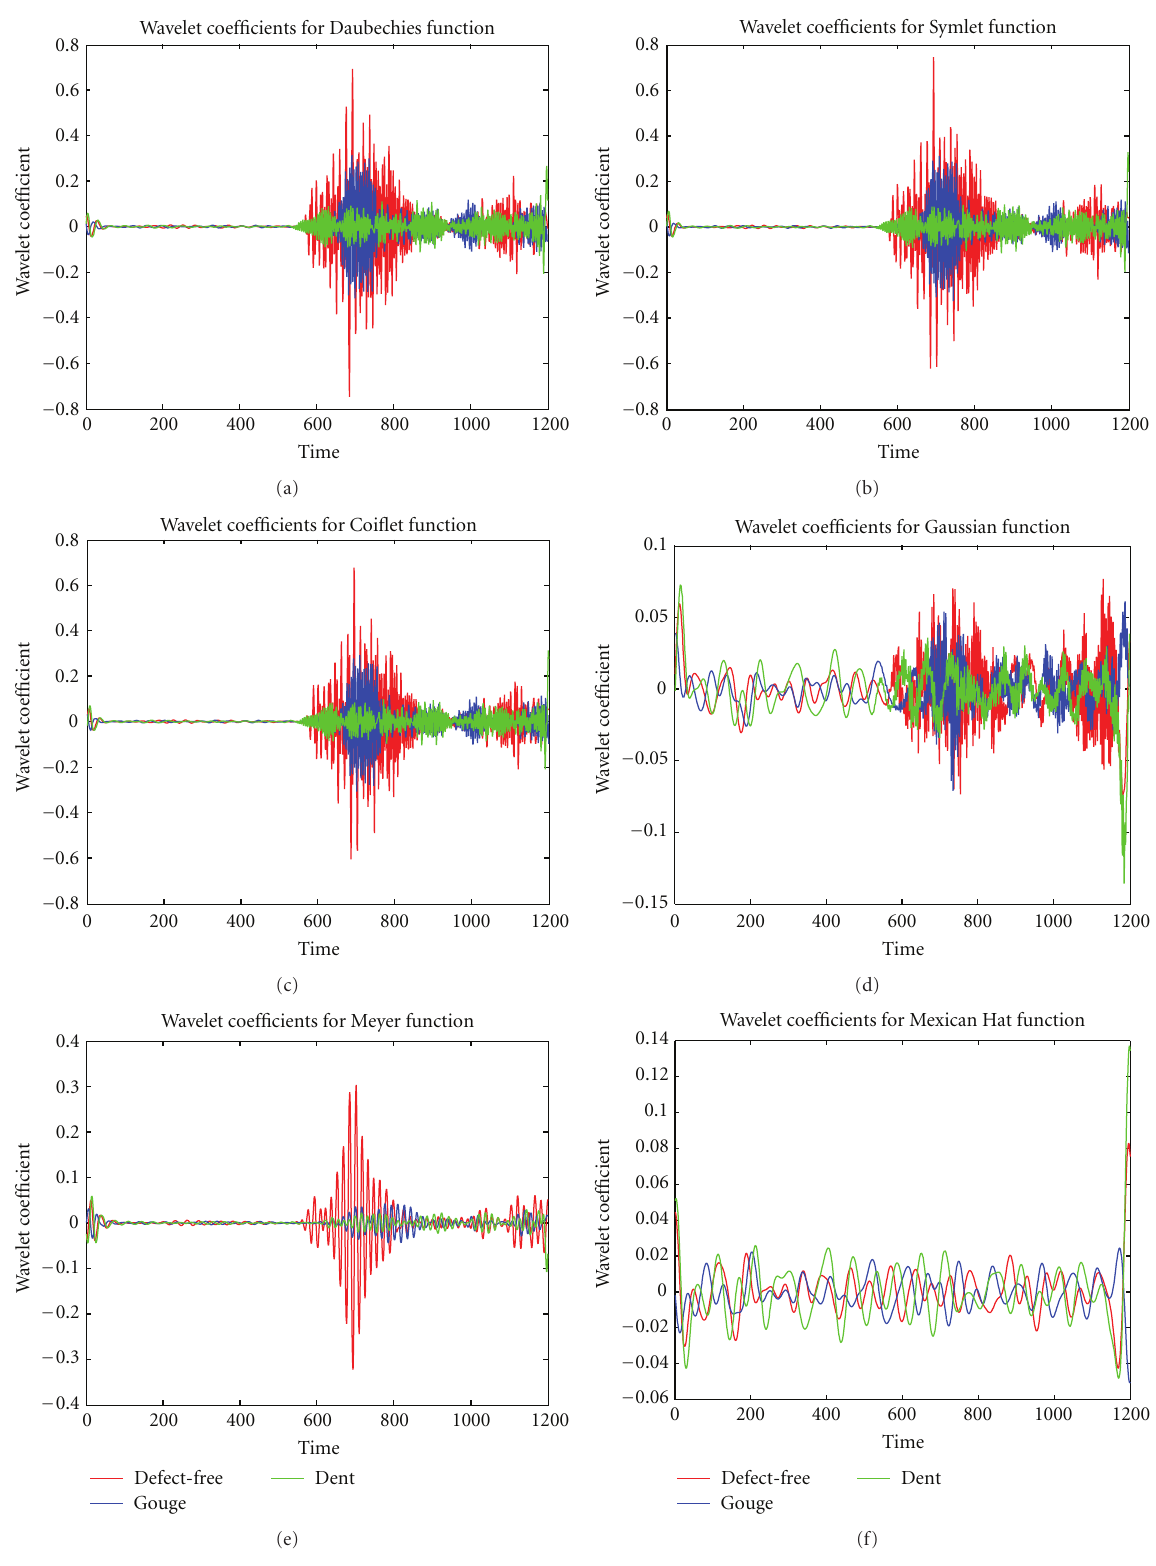
Figure 5: Comparison of experimental signals for defective and defect-free pipes using di ff erent wavelet functions with a scale of 16 for (a) db4, (b) sym4, (c) coif2, (d) gauss1, (e) Meyer, and (f) Mexican hat wavelet